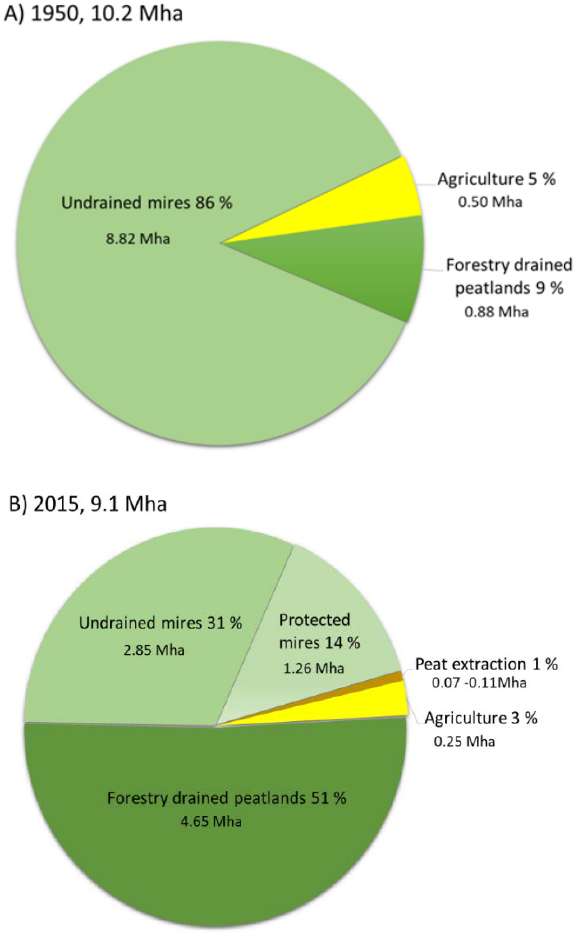
Figure 3. A) Mire exploitation in Finland in 1950 and B) in